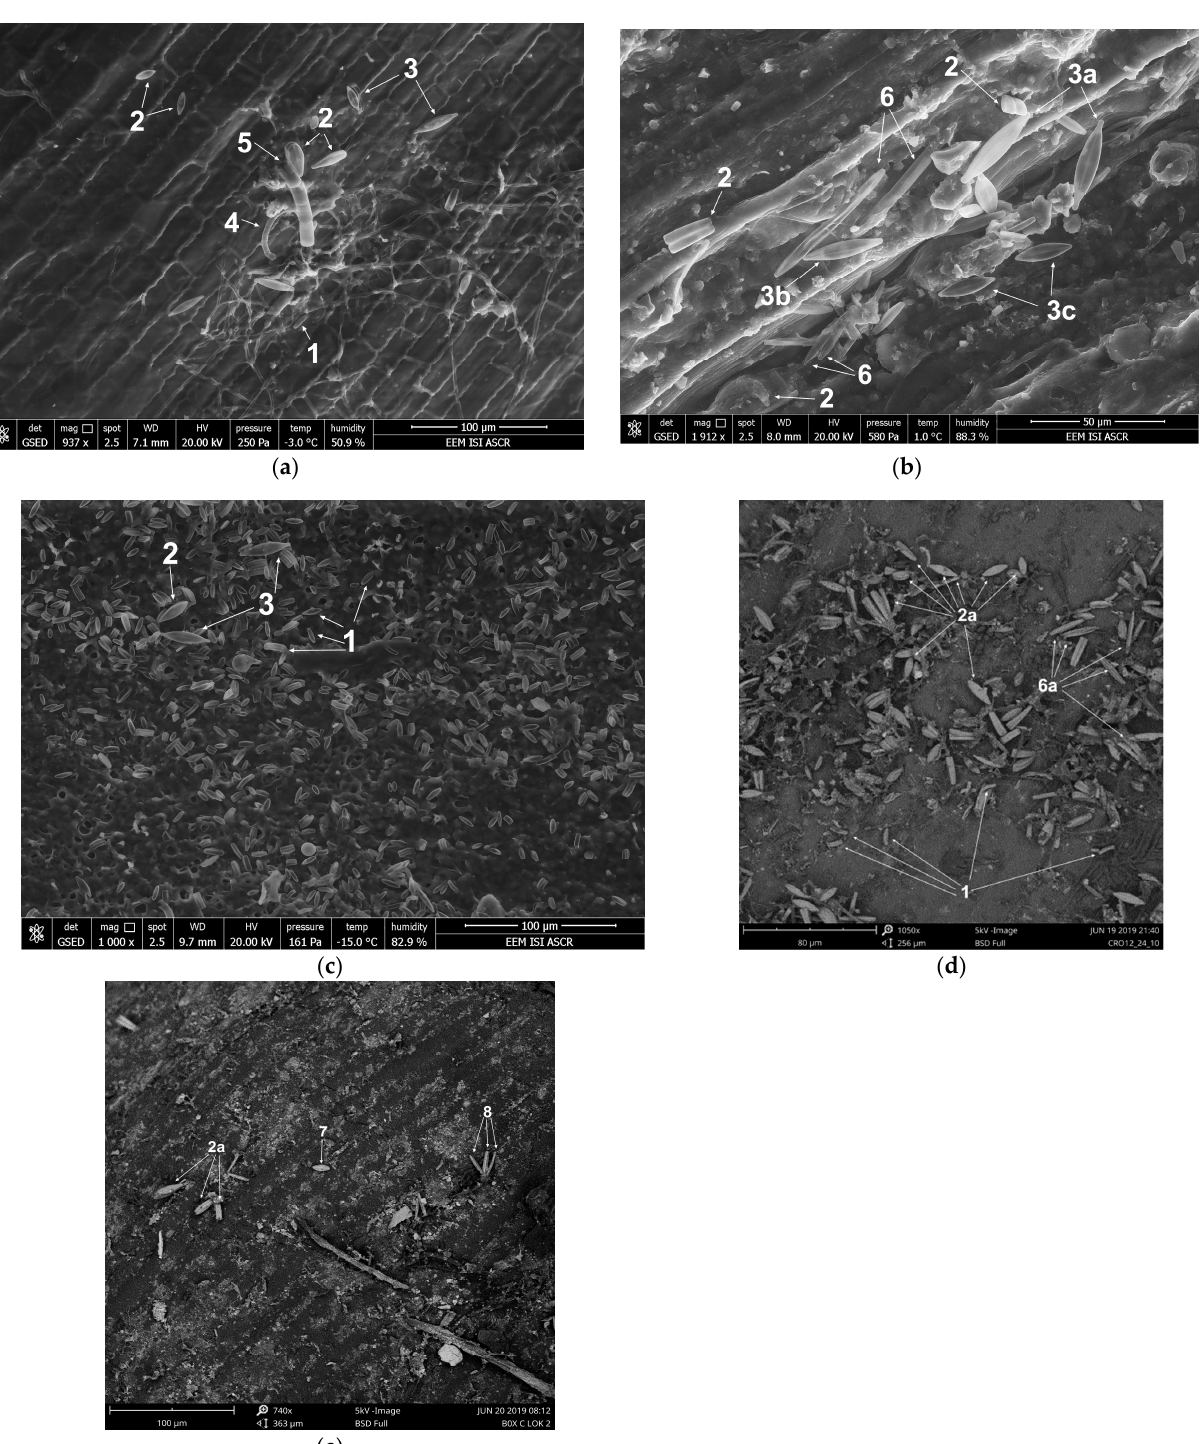
Figure 14. Environmental Scanning Electron Microscopy (ESEM) photographs of the surfaces of selected macrophytes with epiphytic diatom assemblages. ( a ) Phragmites australis leaf collected at BSB in 2016 (sample B12-16, 2 m from the bank) with a sparse epiphytic diatom assemblage consisting mainly of the FT2 ( Achnanthidium sp.—1, Gomphonema spp.—2) and FT5 taxa ( Navicula spp.—3), less frequently of the taxa from FT1 ( Aulacoseira sp.—4) and FT3 functional groups ( Melosira sp.–5); ( b ) Phalaris arundinacea leaf sheath collected at BSB in 2016 (sample B13-16, 1 m from the bank) near the above sample of Phragmites australis . The photo shows the predominance of FT5 diatoms of Navicula spp. ( Navicula capitatoradiata